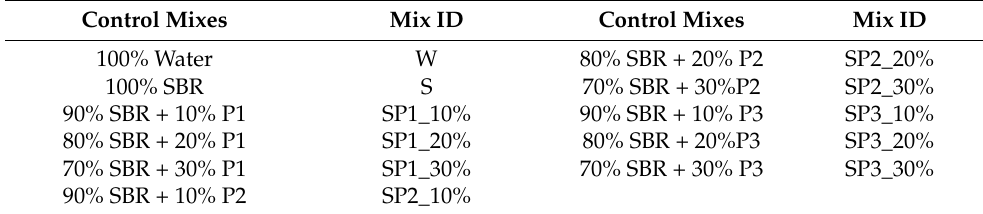
Table 3. Mix proportion of copolymer